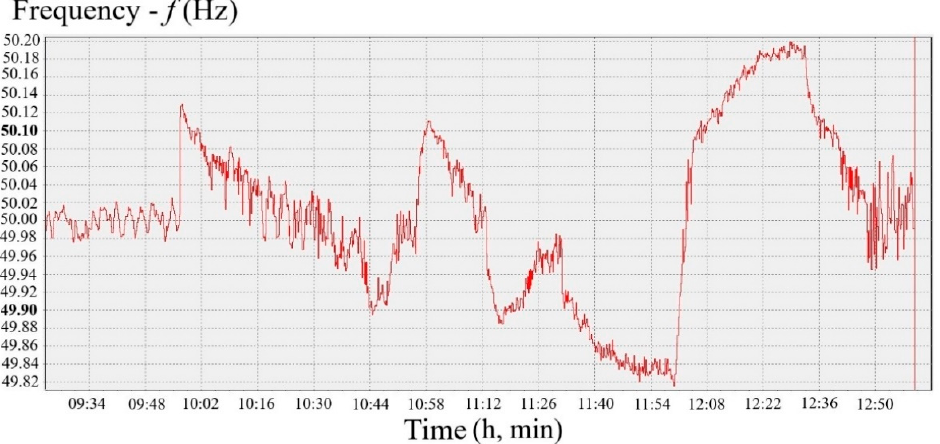
Figure 8. Weather conditions in the PVP area during the full-scale tests. Under the disturbances initiated for the islanded part of the system, the current fre- quency values went beyond the upper limit of the deadband of the general primary fre- quency control three times, f = 50.1 Hz (Figure 9). In these cases, the PVP had to limit the active power output according to Table 1.